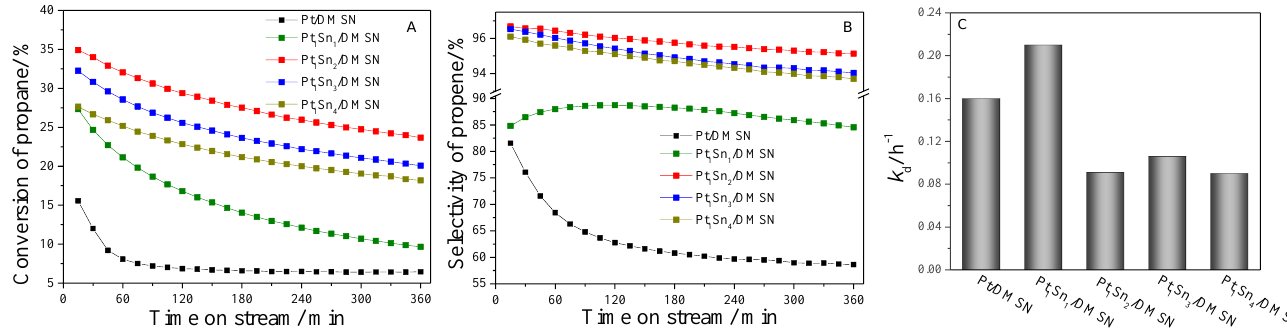
Figure 6. Propane conversion ( A ) and propene selectivity ( B ) during 6 h PDH over PtSn/DMSN catalysts; ( C ) the deactivation rate constant ( k d ) of PtSn/DMSN catalysts. Table 2. Catalytic data of PtSn/SiO 2 catalysts used in the PDH reaction.